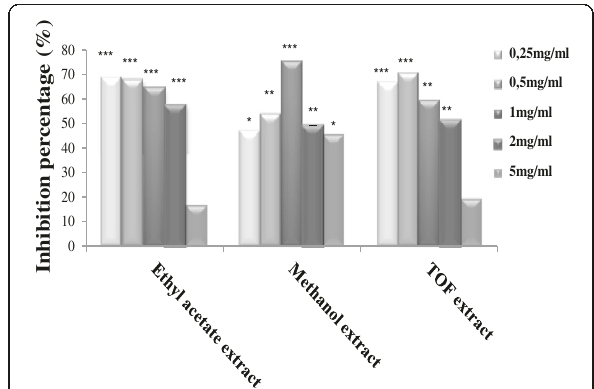
Figure 2 Antioxidant activity of ethyl acetate, methanol and TOF extracts towards superoxide anion generated by the non enzymatic system NBT/Riboflavine. Results were expressed as percentage of inhibition of superoxide anion generation compared to the control. Values represent the mean±SD of three separate experiments. The statistical significance of results was evaluated by the Student ’ s t-test. *P<0.05, **P<0.01, ***P<0.001 means significant difference between control and treated sample.